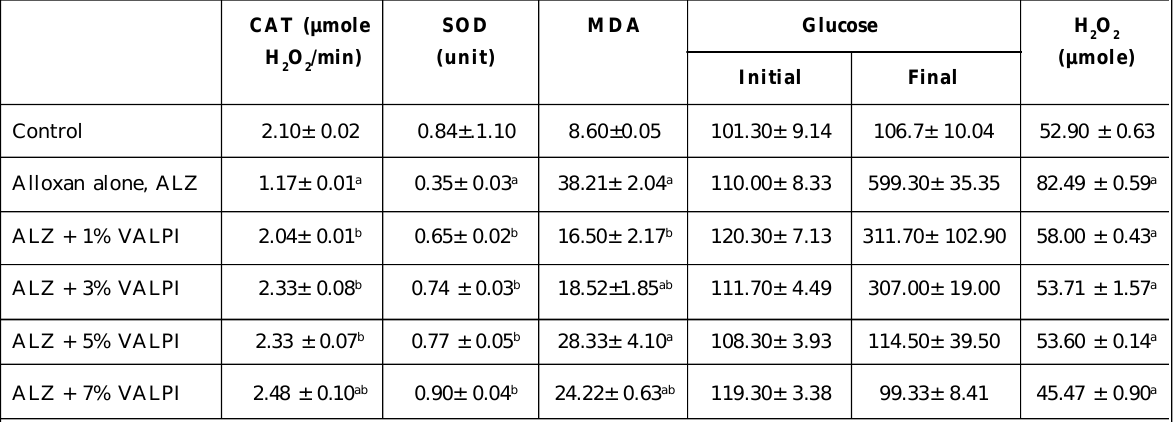
Note: Data are presented as mean ± standard error of mean, n = 5; a = Values differ significantly from control ( p < 0.05); b = Values differ significantly from alloxan only ( p < 0.05); ab = Values differ from control and alloxan alone; VALPI = Vernonia amygdalina leaves protein isolate; and SOD unit = one unit is given as the amount of SOD that caused 50% inhibition of autoxidation of